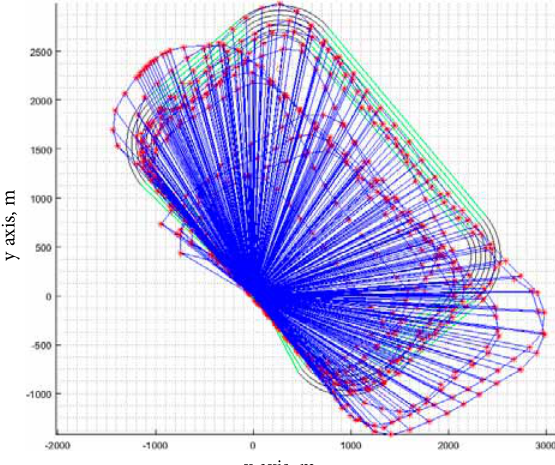
Fig. 12. Measurement of flight distance from runway center point